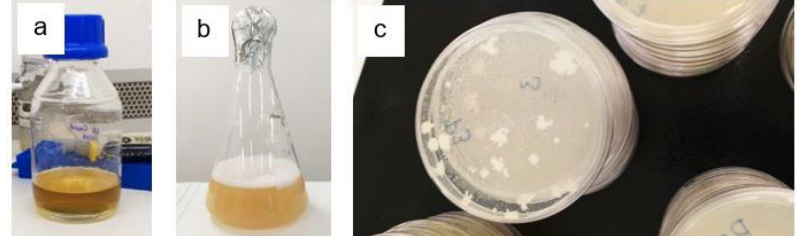
Figure 3 – Procedures for spectrophotometry of B. subtilis AP91: (a) sterile LB Broth, (b) LB broth with bacterial growth and (c) colonies 48h after in an incubator